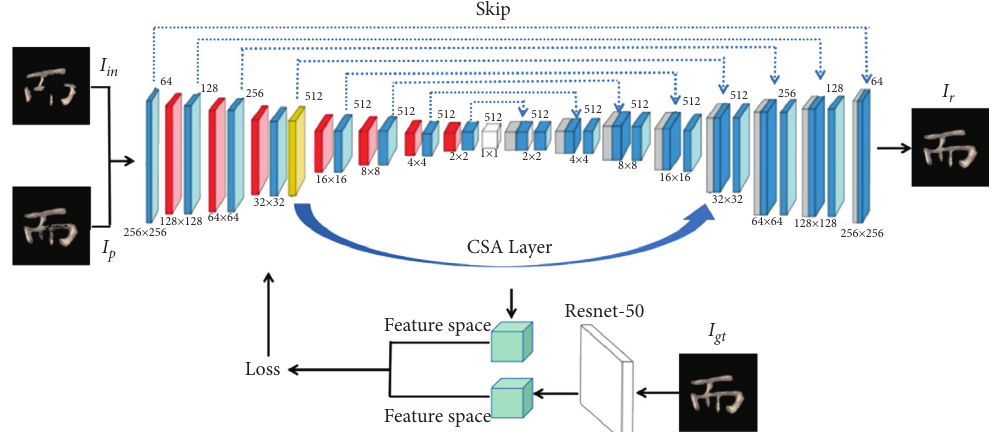
Figure 7: The structure of U-net2.